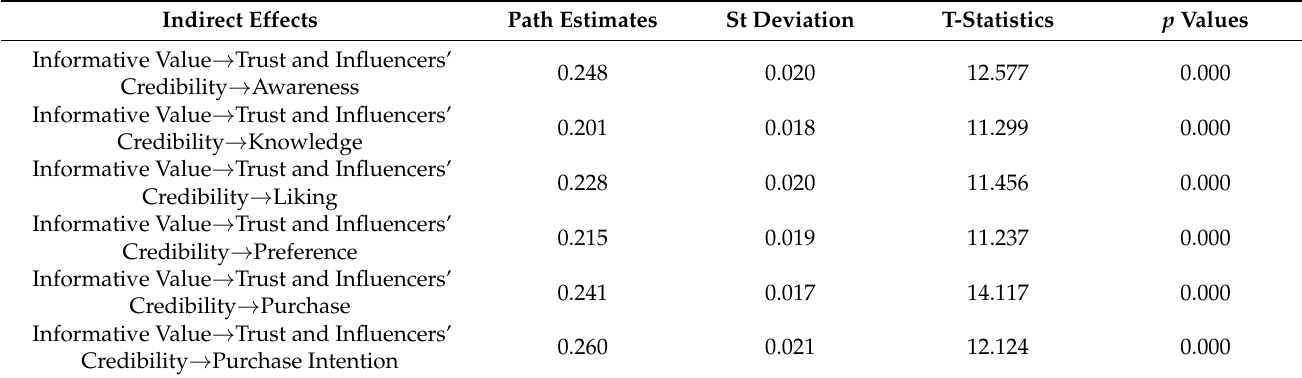
Table 6. Indirect effects path